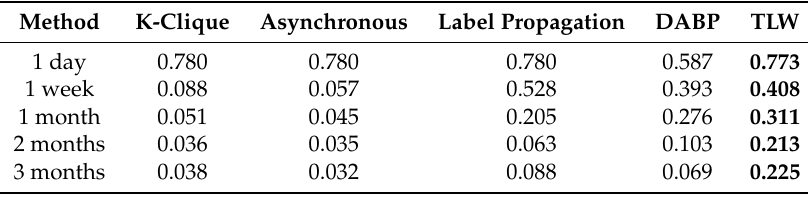
Table 2. The modularity of community structure from different methods tested on Students with the increase of ∆ t .